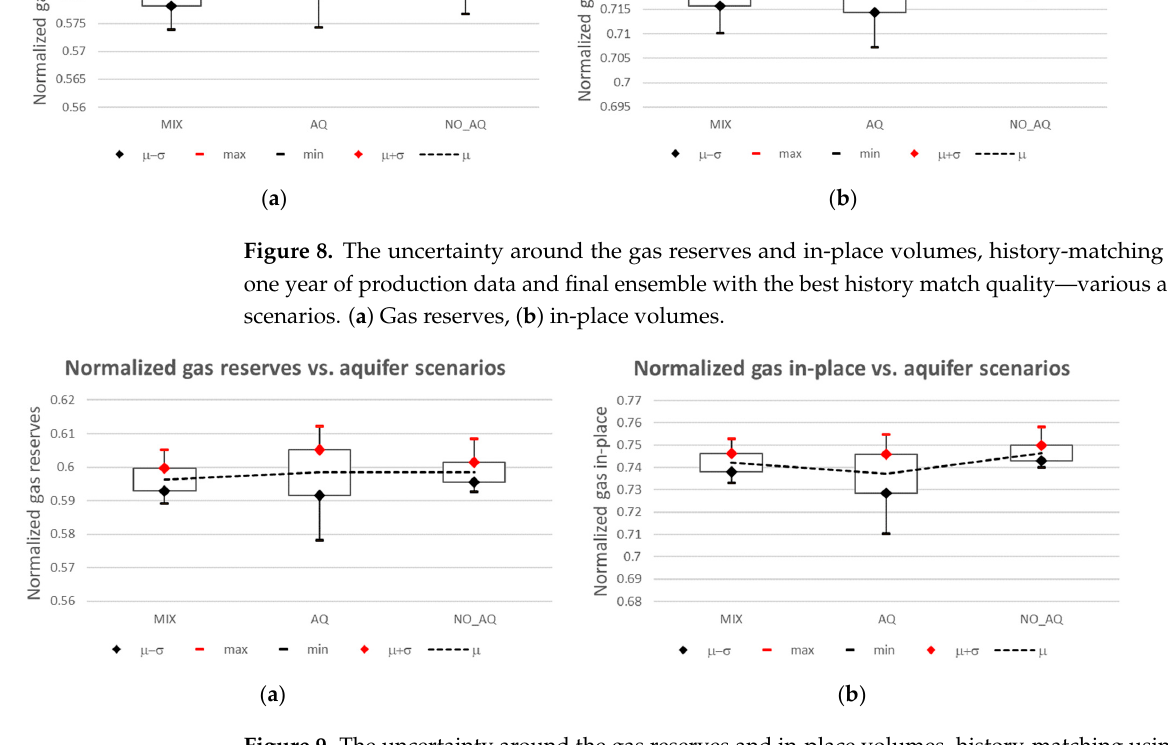
Figure 9. The uncertainty around the gas reserves and in-place volumes, history-matching using two years of production data and final ensemble with the best history match quality—various aquifer scenarios. ( a ) Gas reserves, ( b ) in-place volumes.